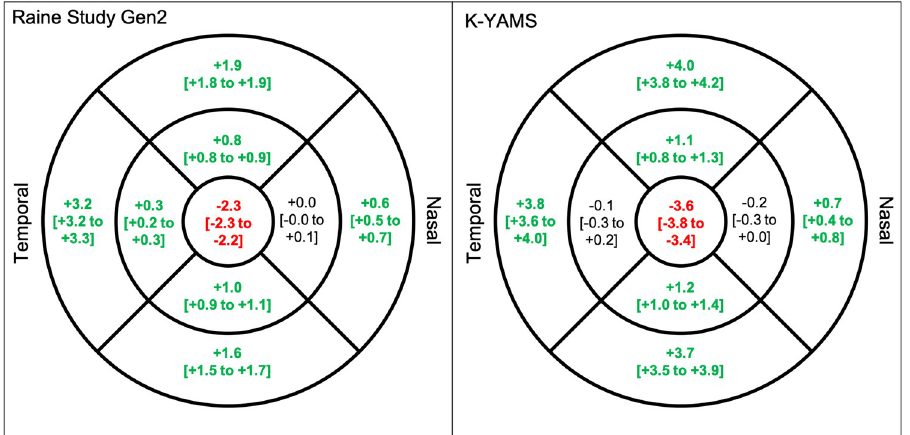
Fig 4. Estimated difference [and 95% confidence interval] in corrected and raw retinal thickness ( μ m) in (left) the Raine Study Gen 2 (mean axial length = 23.6 ± 0.9 mm) and (right) K-YAMS participants (mean axial length = 23.6 ± 1.1 mm). Significant difference (p < 0.05) shown in bold, with red and green values representing underestimation and overestimation by the raw measurements, relative to the transverse magnification-corrected retinal thickness, respectively. Adjusted for sex and ethnicity. Note that the mean axial lengths of both cohorts are shorter than that assumed by the Spectralis SD-OCT (24.385 mm).